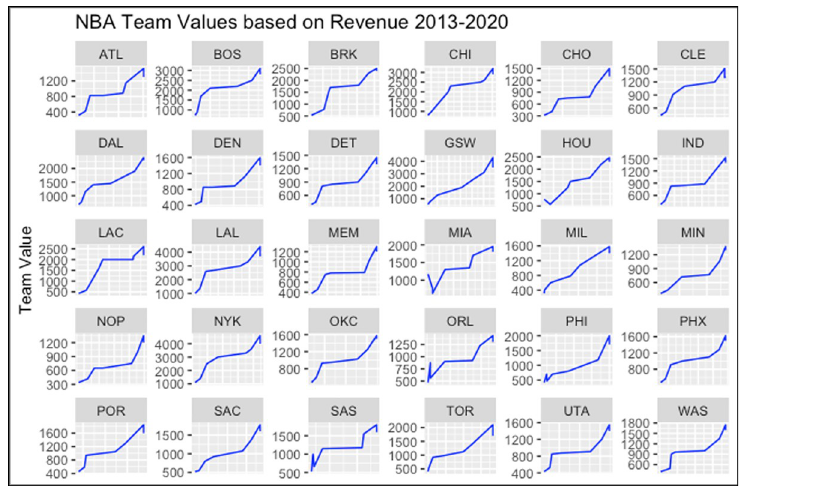
Fig 3. NBA team’s values vs revenues.